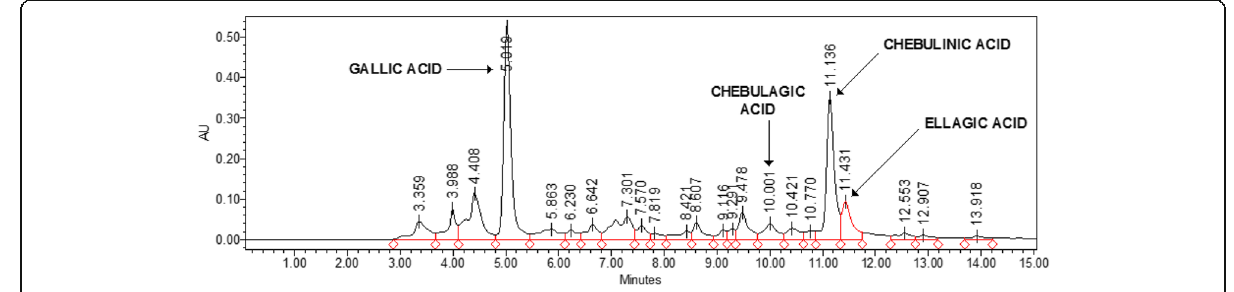
Fig. 1 HPLC Chromatogram of Terminalia chebula aqueous extract